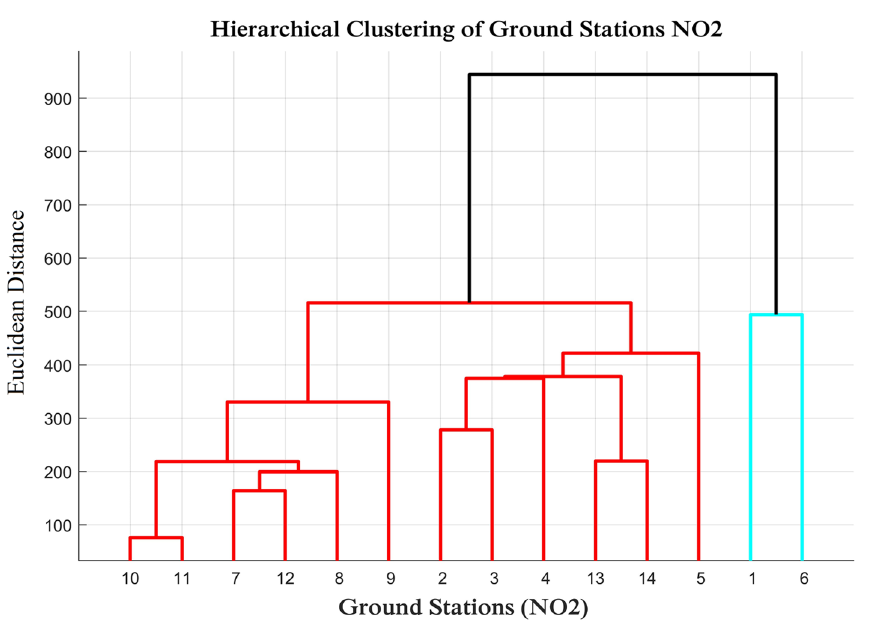
Figure 2. Hierarchical clustering of the ground stations based on their NO 2 concentration profiles over the period of 2019–2020. The lower the Euclidean distance is, the more similar the NO 2 concentration profiles of the two stations